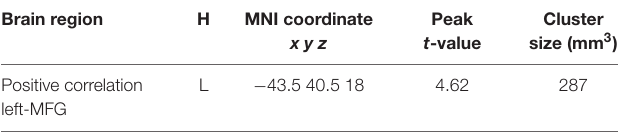
TABLE 2 | Summary of the gray matter density associations with angry rumination. Brain region H